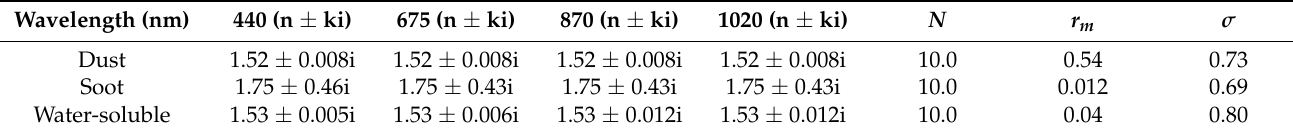
Table 7. Complex refractive index and true value for three aerosol